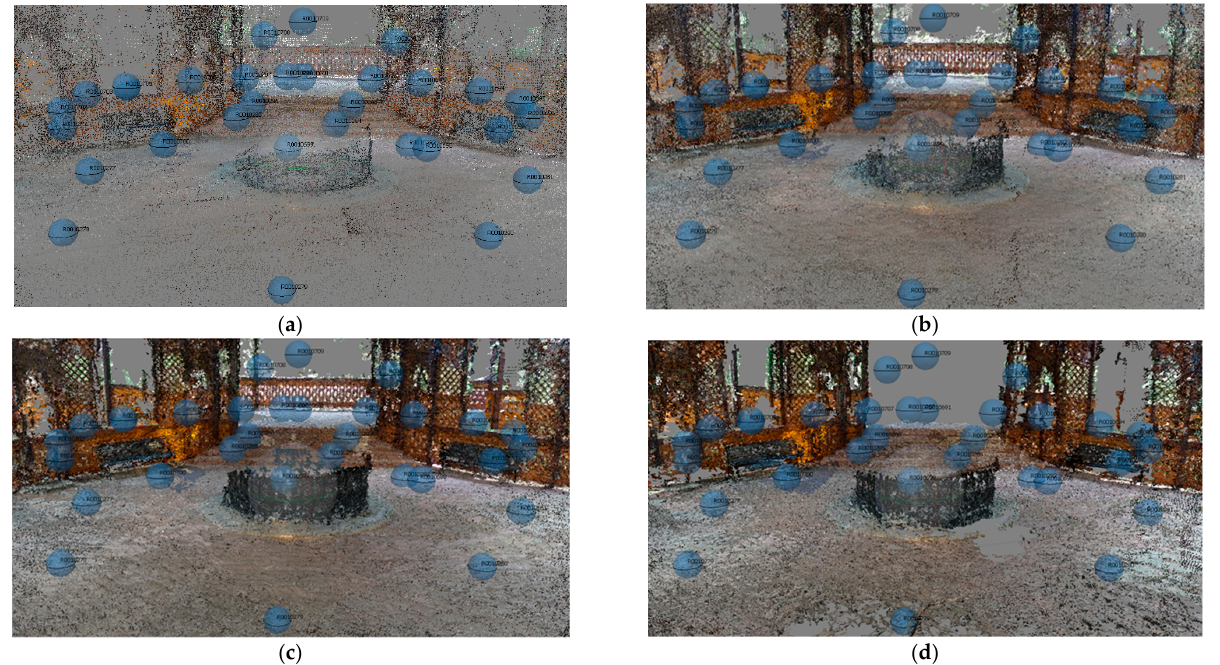
Figure 9. Dense Point Cloud of part of Buzia ș dataset generated by Low ( a ), Medium ( b ) High ( c ) and Highest setting ( d ). and Highest setting ( d